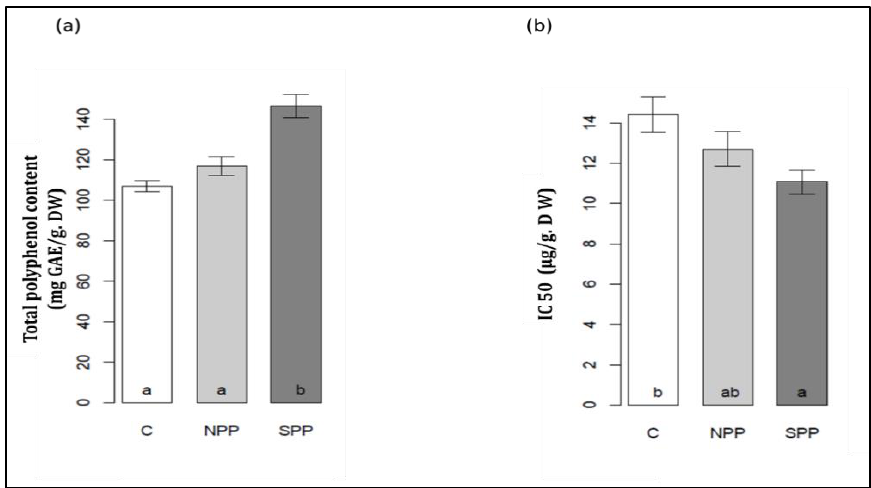
Figure 10. Effect of cross-tolerance on phenol content ( a ) and antioxidant activity ( b ) of olive leaves subjected to subsequent drought stress. Significant differences between the means (at p < 0.05, according to ANOVA) appear with different letters. Values are means ± standard error ( n = 6), where ‘ n ’ is the number of replicates for each group.